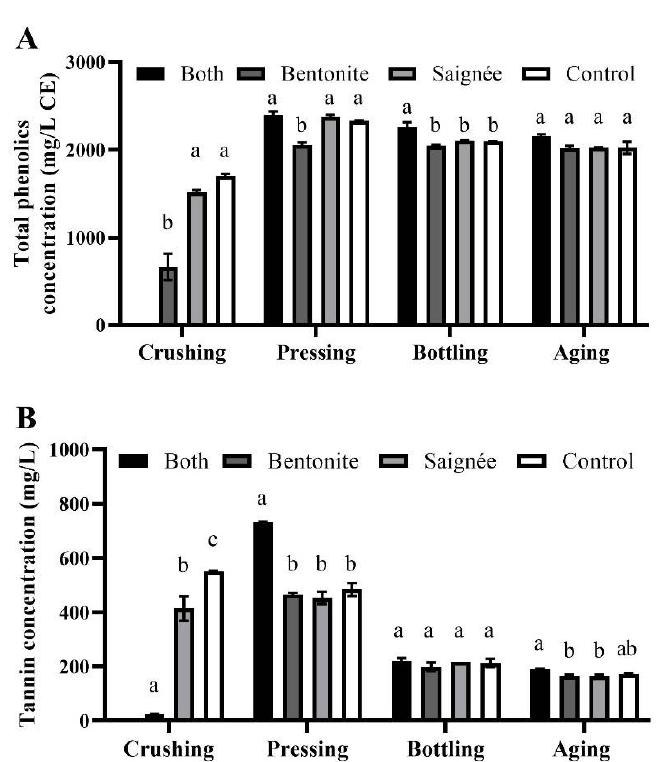
Figure 2. ( A ) Total iron-reactive phenolic compounds content, (+)-Catechin (CE) equivalent and ( B ) Tannin concentration in Marquette grape musts and red wines throughout the winemaking process. The error bars represent standard deviation of the mean ( n = 2). Lowercase letters indicate significant difference ( p -value < 0.05) among treatments within same time point. “Both” means saignée plus bentonite treatment. There was no “both” treated sample collected at crushing.